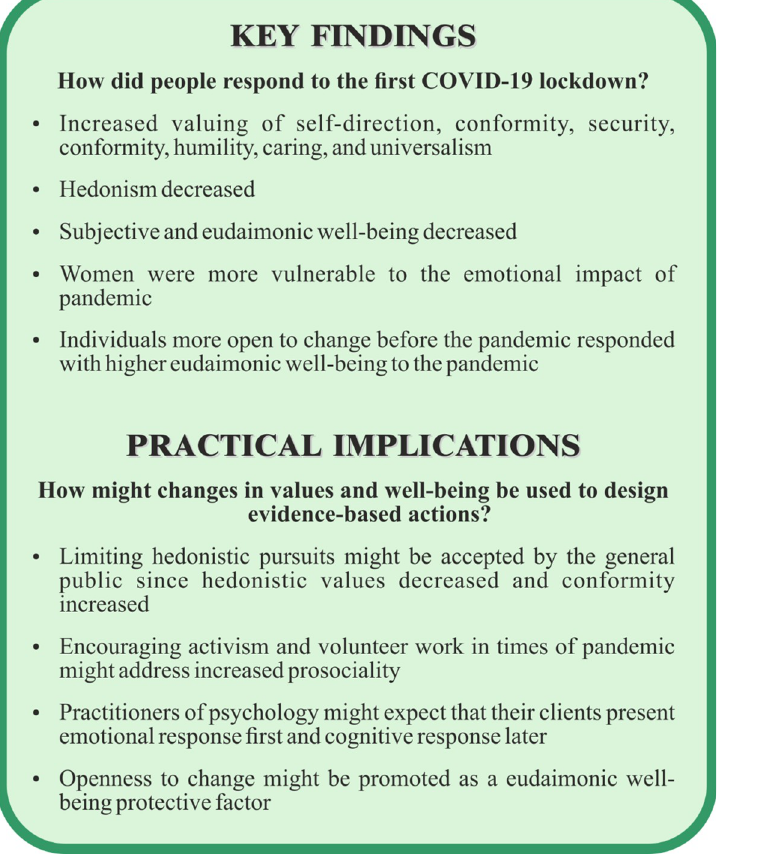
Fig 2. Summary of the findings and practical